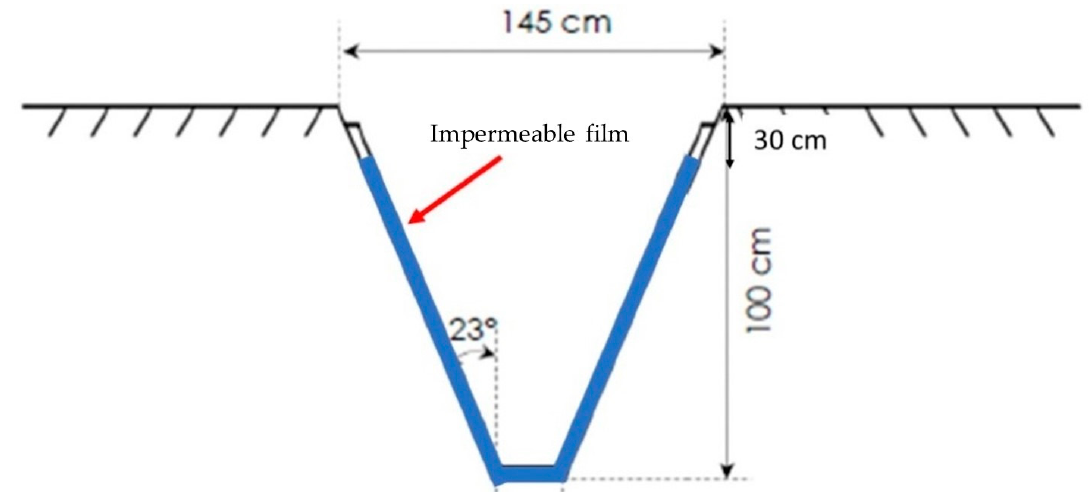
Figure 3. Schematic transversal view of the SWRS and impermeable film positioning. Table 3. Physical parameters of the